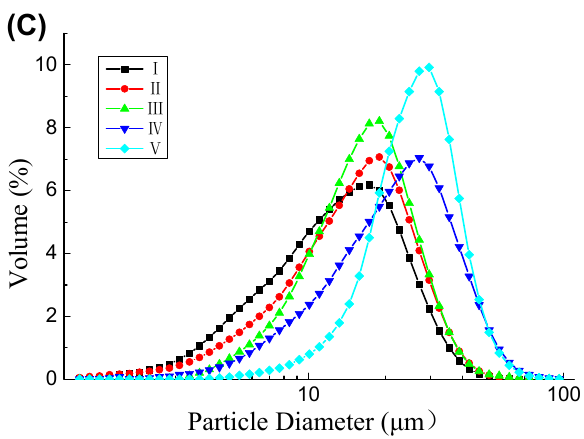
Figure 3. Particle size distribution of ( A ) primary emulsions (a, b, c, d, and e represent protein content of 0.8 g/100 g, 1.8 g/100 g, 2.8 g/100 g, 3.8 g/100 g, and 4.8 g/100 g, respectively); ( B ) secondary emulsions (1, 2, 3, 4, and 5 represent protein content of 3.8 g/100 g and SBP content of 0.01 g/100 g, 0.02 g/100 g, 0.05 g/100 g, 0.10 g/100 g, and 0.15 g/100 g, respectively); and ( C ) laccase-treated secondary emulsions (I, II, III, IV, and V represent protein content of 3.8 g/100 g, SBP content of 0.10 g/100 g, and laccase content of 2 U/100 g, 4 U/100 g, 6 U/100 g, 8 U/100 g, and 10 U/100 g, respectively). Table 1. D[4,3] of the primary, secondary, and laccase-treated secondary emulsions. Protein (g/100 g) SBP (g/100 g) Laccase